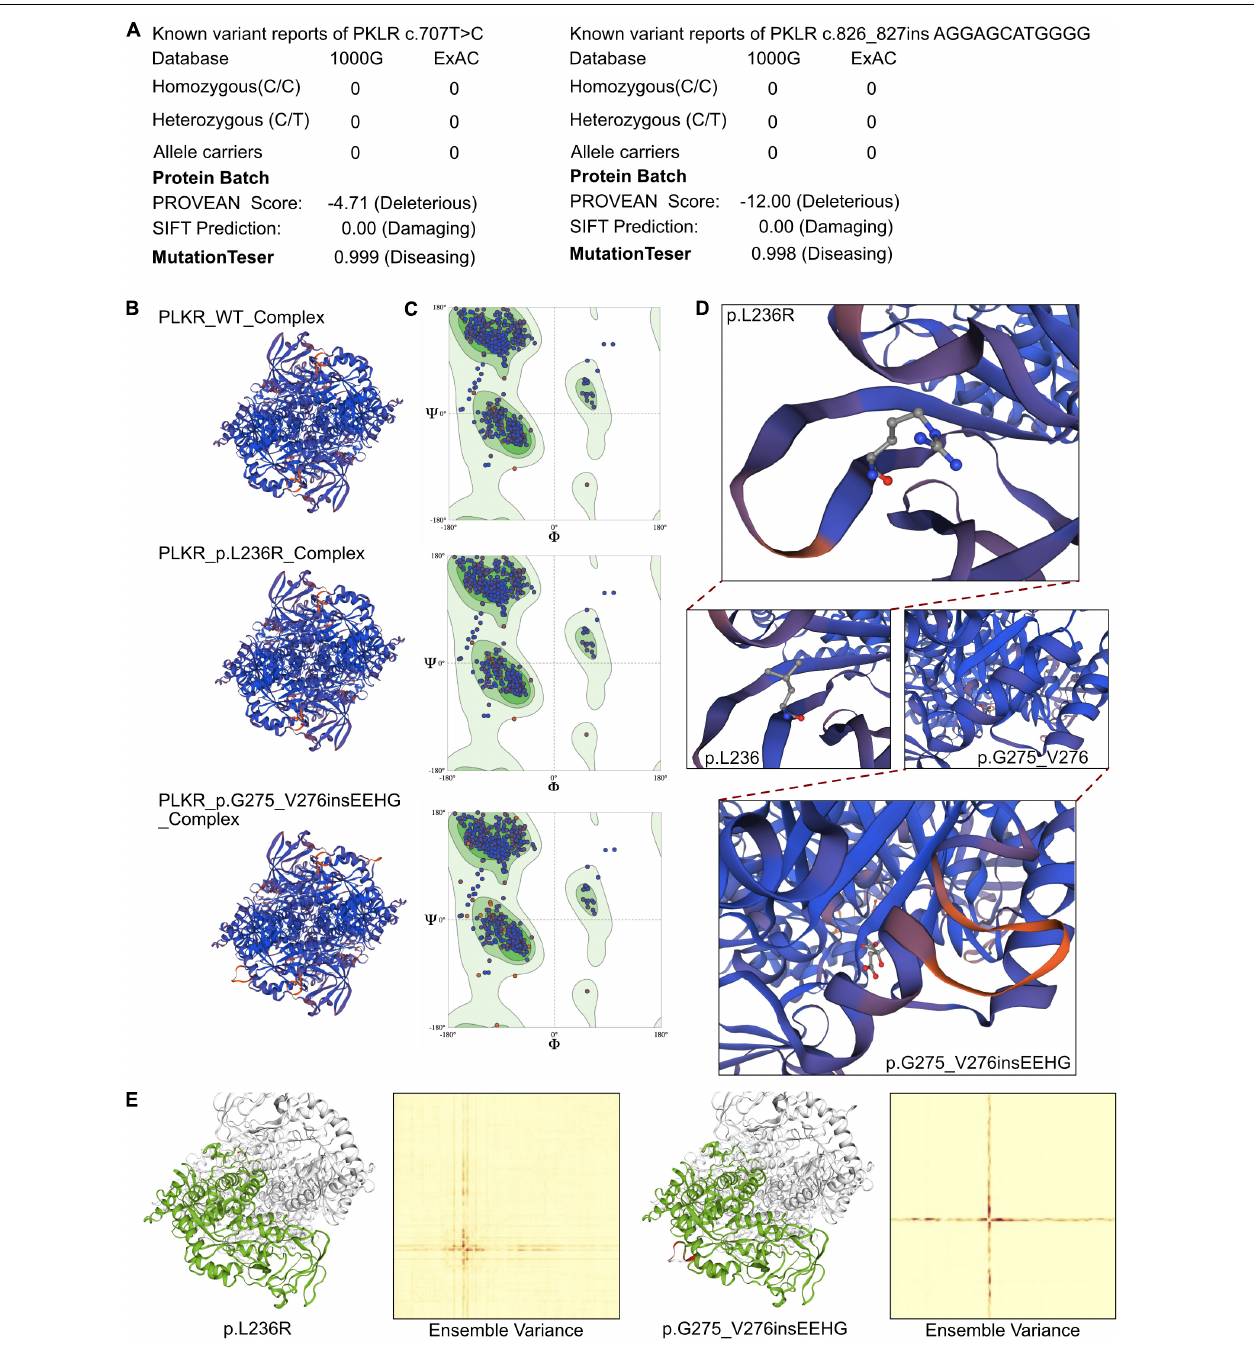
FIGURE 3 | The effects of PKLR c.707T > C and c.826_827insAGGAGCATGGG mutations on the molecular structure of the protein. (A) The reported cases of the identified mutations in database 1000G and ExAC. And the PROVEAN protein batch and MutationTaster scores revealed the two newly identified mutations would be protein damaging and diseasing causing variants. (B) Individual crystal structures of wild type, p.L236R and p.G275_V276insEEHG according to the 36eck.1.A model template. (C) Ramachandran plots of AA with wild type, p.L236R and p.G275_V276insEEHG. (D) The detailed space structure between wild type and mutant proteins. (E) The comparisons of free energy on crystal structure of wild type sequence and p.L236R and p.G275_V276insEEHG variants,